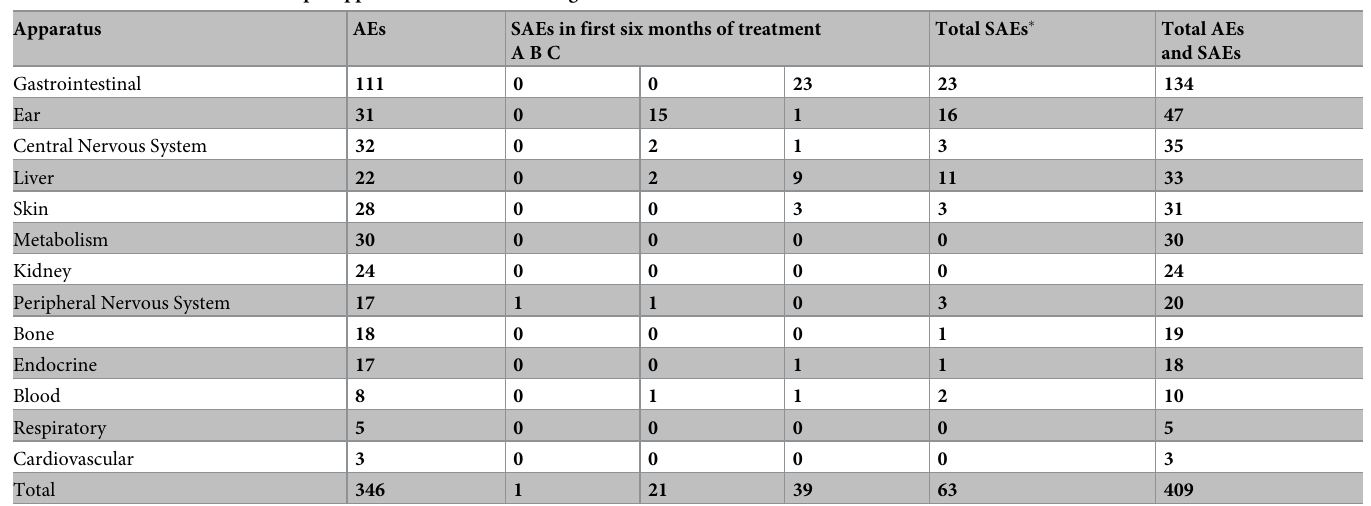
Table 2. Number of AEs and SAEs per apparatus and clinical